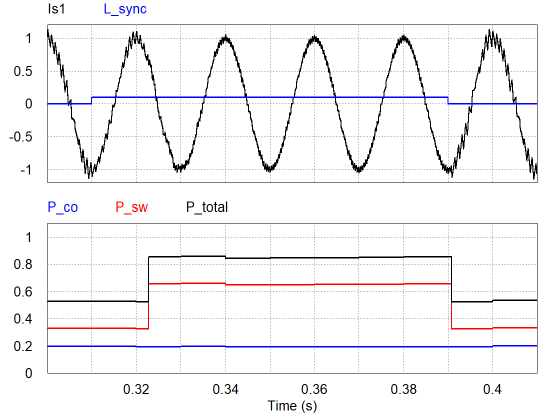
Figure 24. Conduction and switching losses in normal and degraded conditions (resonance starts at t =0.31 s). Traces: Is1 - AC current of converter 1, L_sync - loss of synchronism, P_co - conduction losses, P_sw - switching losses, P_total - total losses.